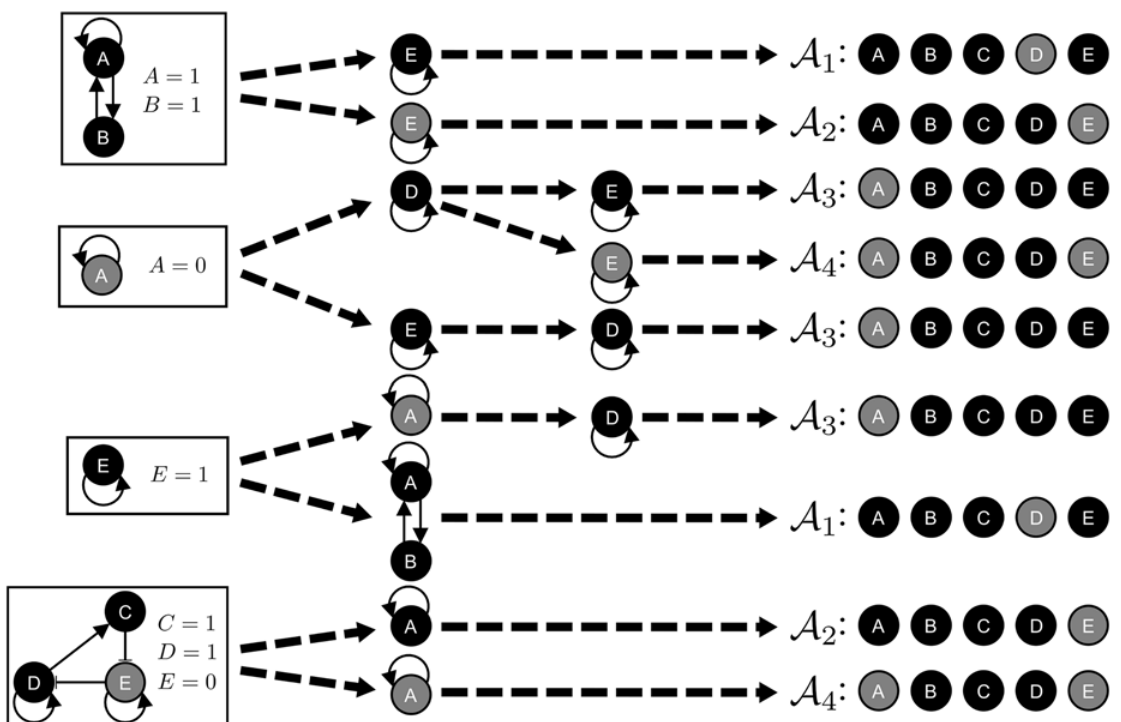
Fig 2. Stable motif succession diagram for the example in Fig 1. The stable motif succession diagram shows the stable motifs obtained successively during the attractor finding process and the attractors they finally lead to. A more detailed representation of the first steps of the attractor finding method is shown in S1 Fig. Nodes are colored based on their respective node states in the motifs or the attractors: gray for 0 and black for 1. The four stable motifs of the original logical network and their matching node states are shown in the leftmost part of the figure. The attractors obtained for each possible sequence of stable motifs are shown in the rightmost part of the figure. The result of applying network reduction using a stable motif is represented by each dashed arrow. If network reduction due to a stable motif leads to a simplified network with at least one stable motif, then the dashed arrows point from the stable motif being considered to the stable motifs of the simplified network. Otherwise, network reduction leads directly to an attractor and the dashed arrow points towards the attractor.